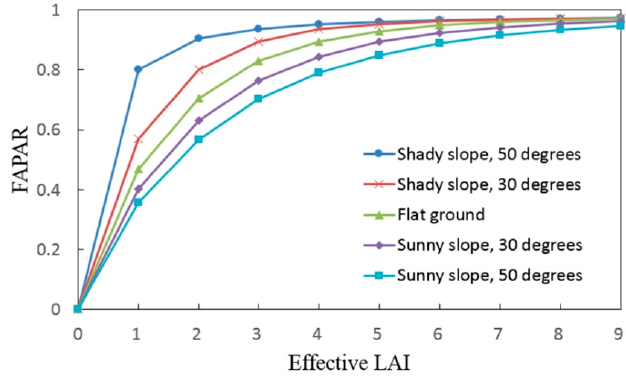
Figure 6. The relation between the fraction of absorbed photosynthetically active radiation (FAPAR) and the effective leaf area index (LAI) at different slopes and aspects.